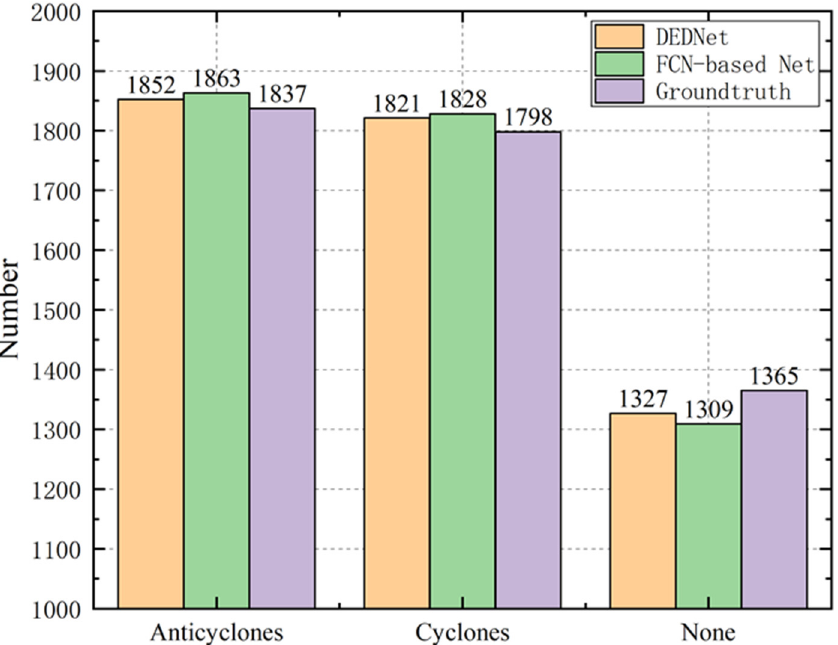
Figure 7. The different eddy types detected by the ground truth, FCN-based eddy network, and DEDNet.